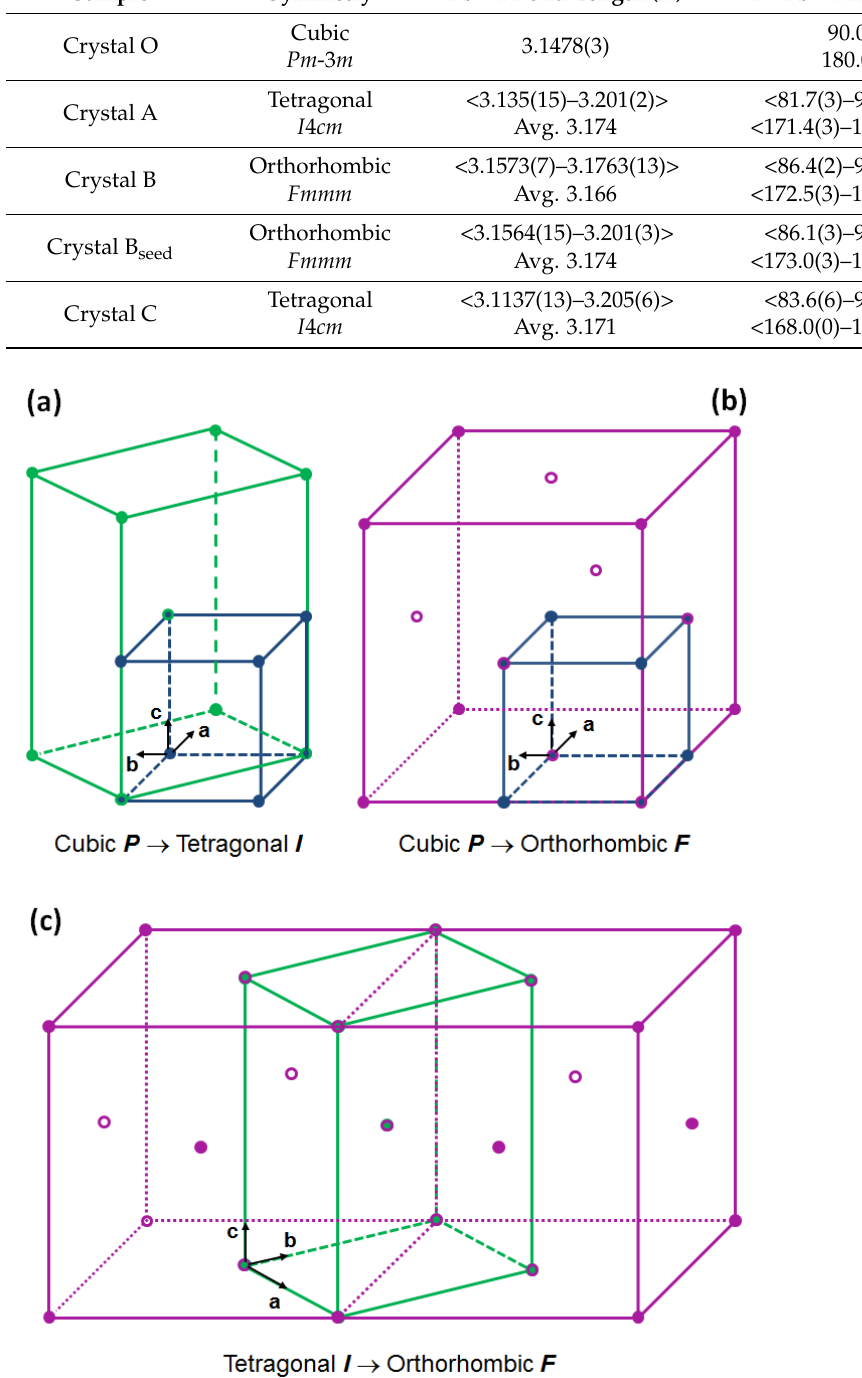
Figure 6. Schematic representation illustrating the symmetry relationship among the unit cells of the studied MAPI: ( a ) transformation from the cubic cell P to the tetragonal I ; ( b ) from the cubic P to the orthorhombic F ; and ( c ) from the tetragonal I to the orthorhombic F . Taking into account the geometry relationship between the MAPI crystal structures and considering the intimate twinning, each MAPI reported herein was described in the symmetry that best fits its diffraction